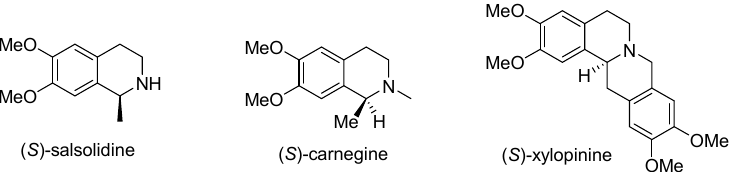
Figure 1. Examples of bioactive natural products containing chiral C1-substituted tetrahydroiso- quinolines.